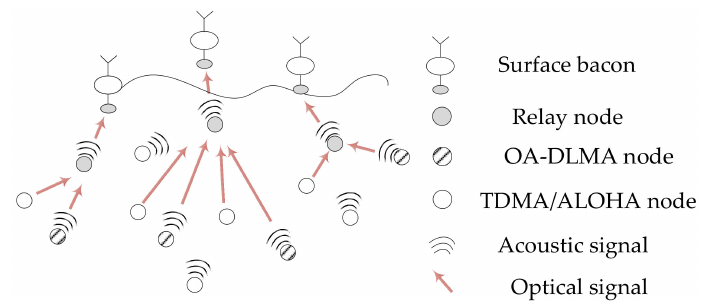
Figure 2. A heterogeneous UWSN consists of multiple source nodes and relay nodes, where source nodes can transmit data packets to the relay node through optical or acoustic